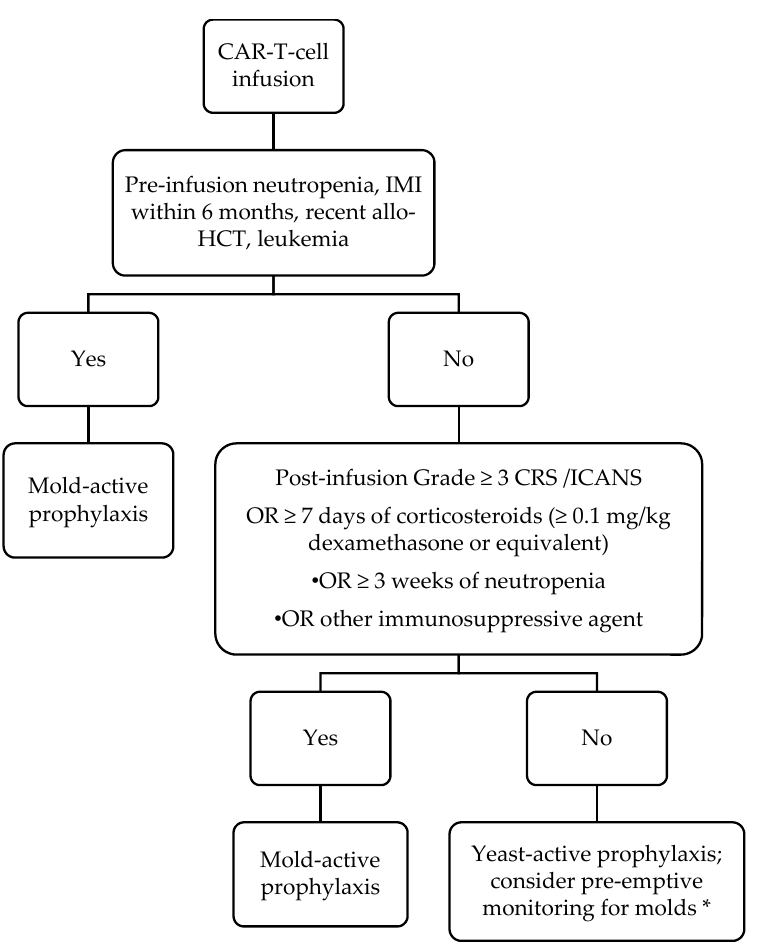
Figure 1. Our approach to anti-fungal prophylaxis for prevention of invasive fungal infection post-chimeric antigen receptor-modified T-cell (CAR T-cell) therapy. Abbreviations: IMI = invasive mold infection; allo-HCT = allogeneic hematopoietic cell transplantation; CRS = cytokine release syndrome; ICANS = immune effector cell-associated neurotoxicity syndrome. For our purposes, we define neutropenia as an absolute neutrophil count of ≤ 500/ µ L. Duration of mold-active prophylaxis should be individualized. We maintain patients on mold-active agents until at least 1 month after dis- continuation of immunosuppression AND resolution of neutropenia. Posaconazole is our preferred agent; voriconazole and isavuconazole are reasonable alternatives based on side effect profile and cost. * Pre-emptive therapy consists of diagnostics such as fungal biomarkers (serum beta-D-glucan, galactomannan) and surveillance radiographic